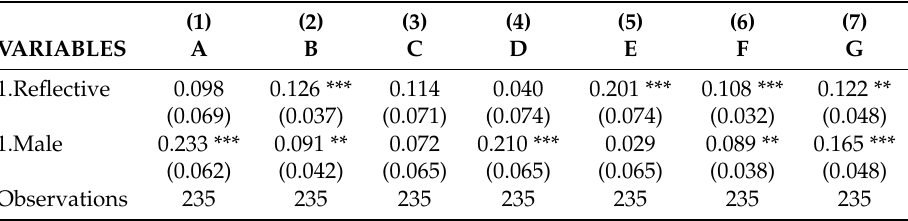
Table 1. Marginal effects from Logistic